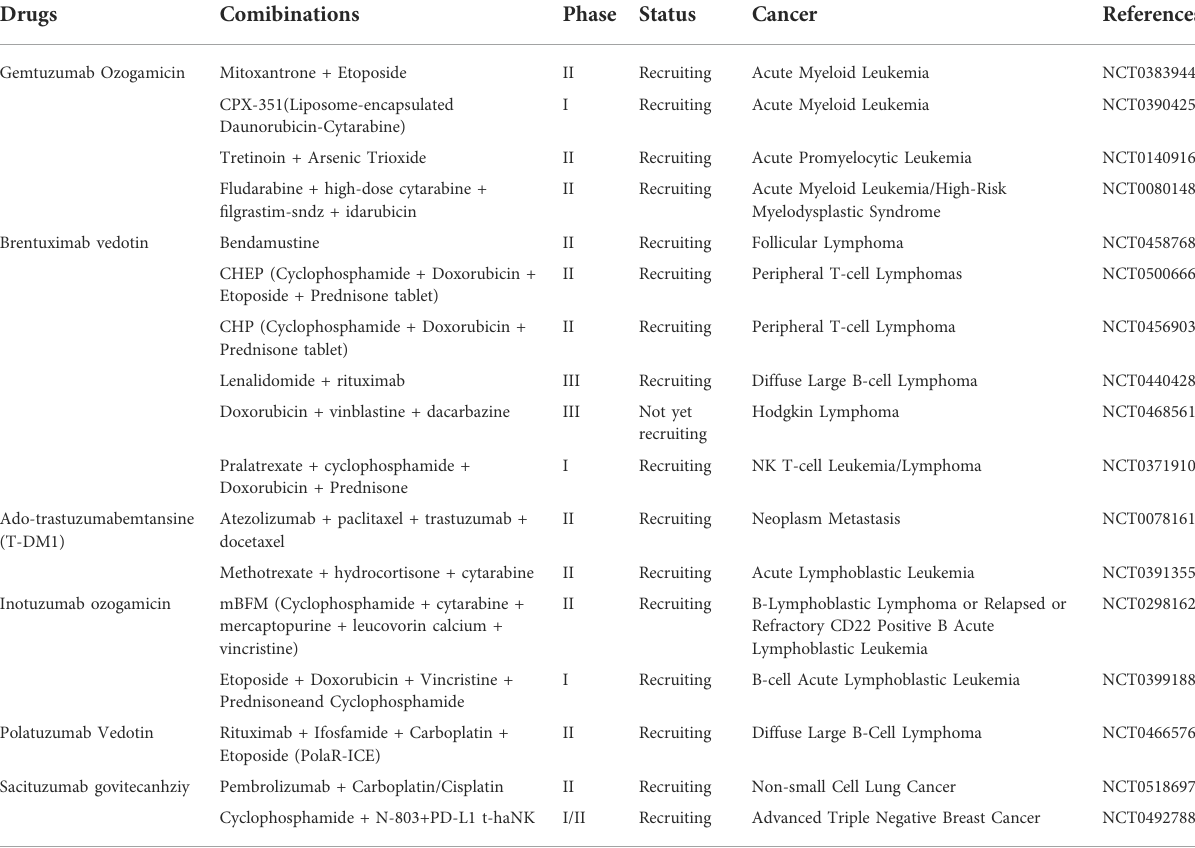
TABLE 1 Clinical trials on combination regimens of ADC and chemotherapy in cancers.